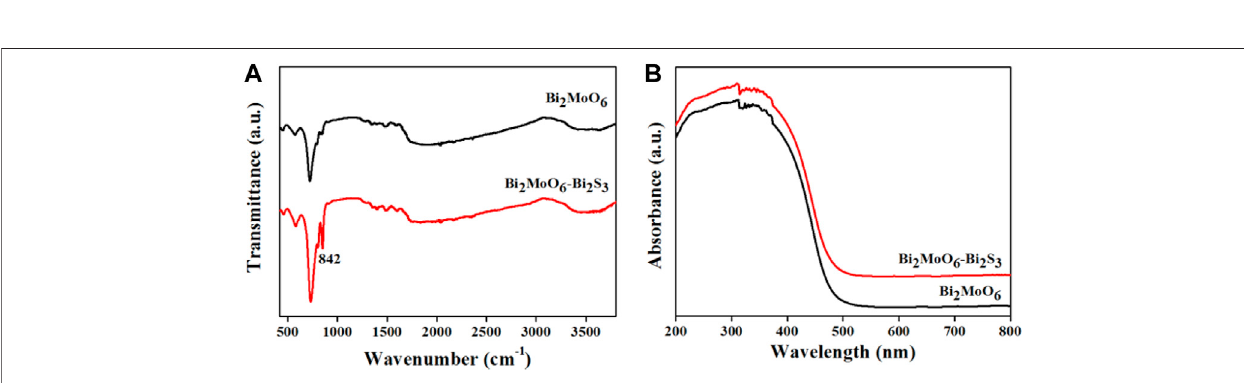
Frontiers in Chemistry |